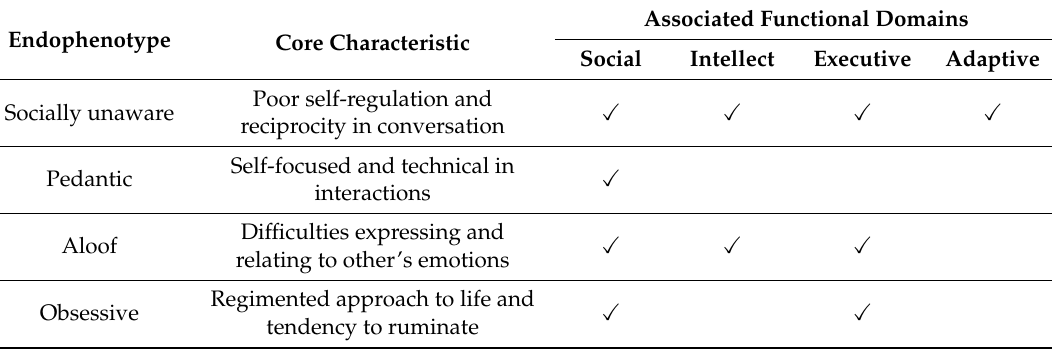
Table 4. Summary of the BAP endophenotypes and their functional